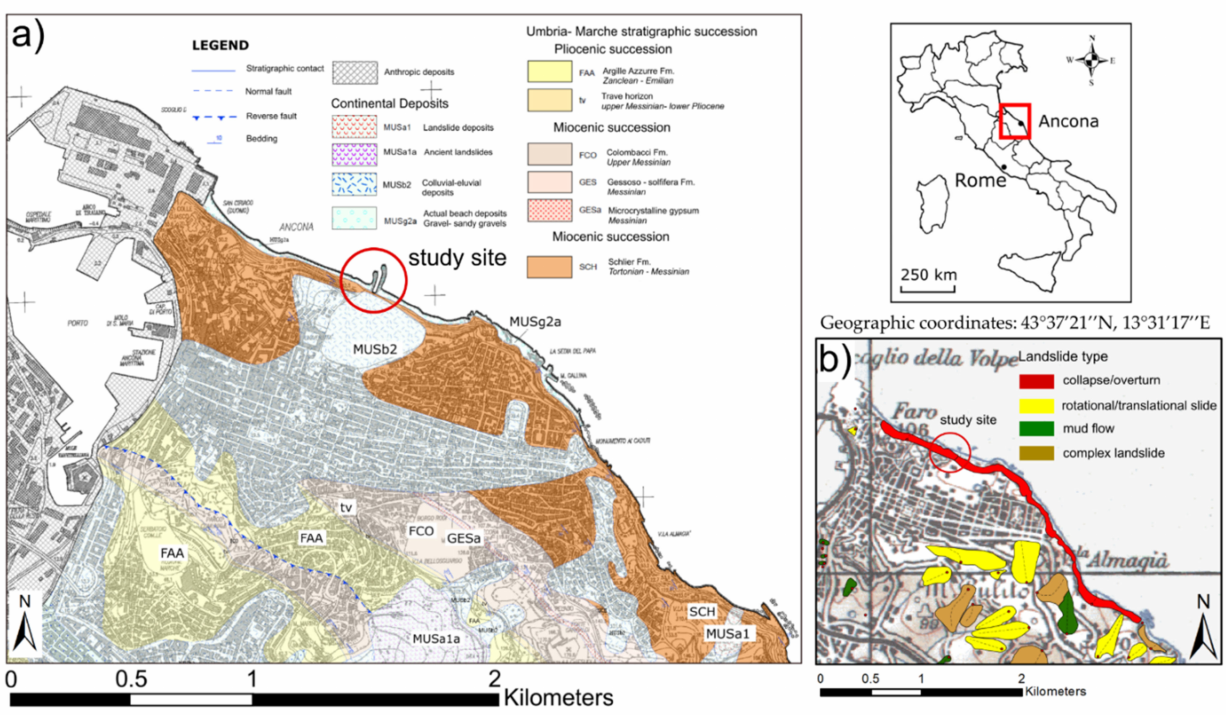
Figure 1. ( a ) Geological map of the study area (modified from [52]); ( b ) landslide map with indication of the landslide type (modified from